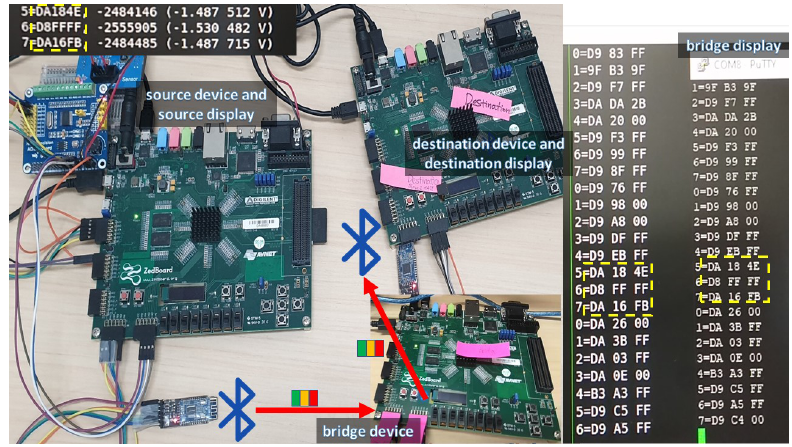
Figure 16. Result of data transmission.